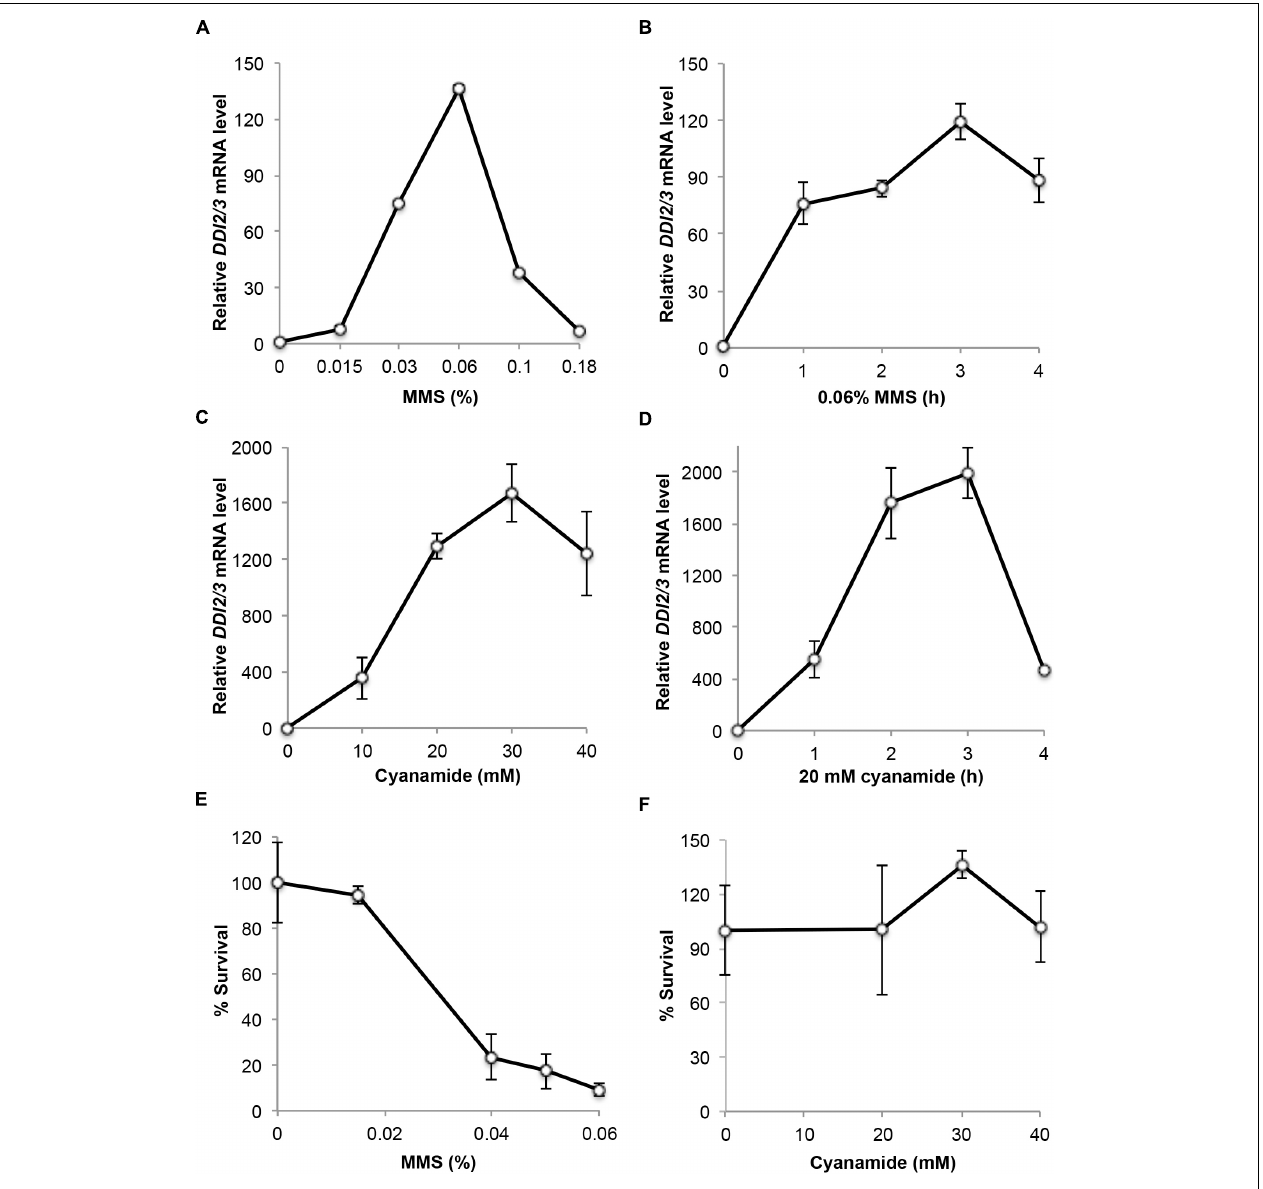
FIGURE 1 | Characterization of endogenous DDI2/3 gene expression and induction. (A–D) Endogenous DDI2/3 gene expression in BY4741 cells was measured by qRT-PCR with DDI2/3 -specific primer pairs 5 (cid:48) -GTTGTTCCGCCTCCAAACAGTG-3 (cid:48) and 5 (cid:48) -CTGCATAGTCCTGATTTCCACC-3 (cid:48) . The yeast UBC6 mRNA was used as an internal control (Teste et al., 2009). The relative DDI2/3 mRNA level with untreated cells in each experiment was set as 1. (A) Dose response to MMS treatment for 2 h. (B) Time course response to 0.06% MMS. (C) Dose response to CY treatment for 2 h. (D) Time course response to 20 mM CY. (E) Cell survival after MMS treatment at the given doses for 2 h. (F) Cell survival after CY treatment at the given doses for 2 h. All data are an average of at least three independent experiments with standard deviations shown as error